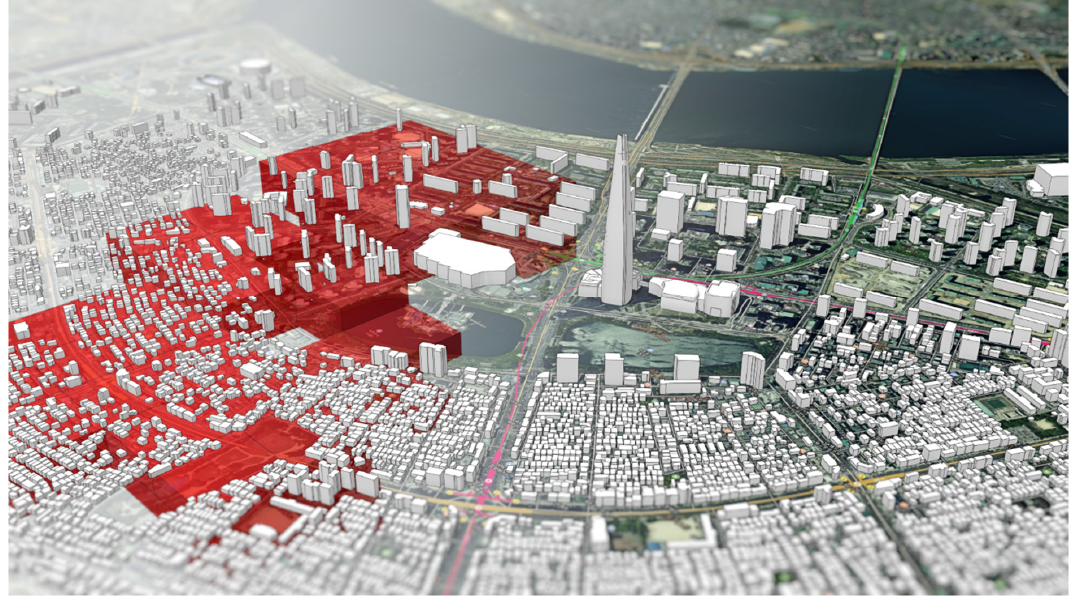
Figure 12. 3D seismic liquefaction hazard web mapping application .